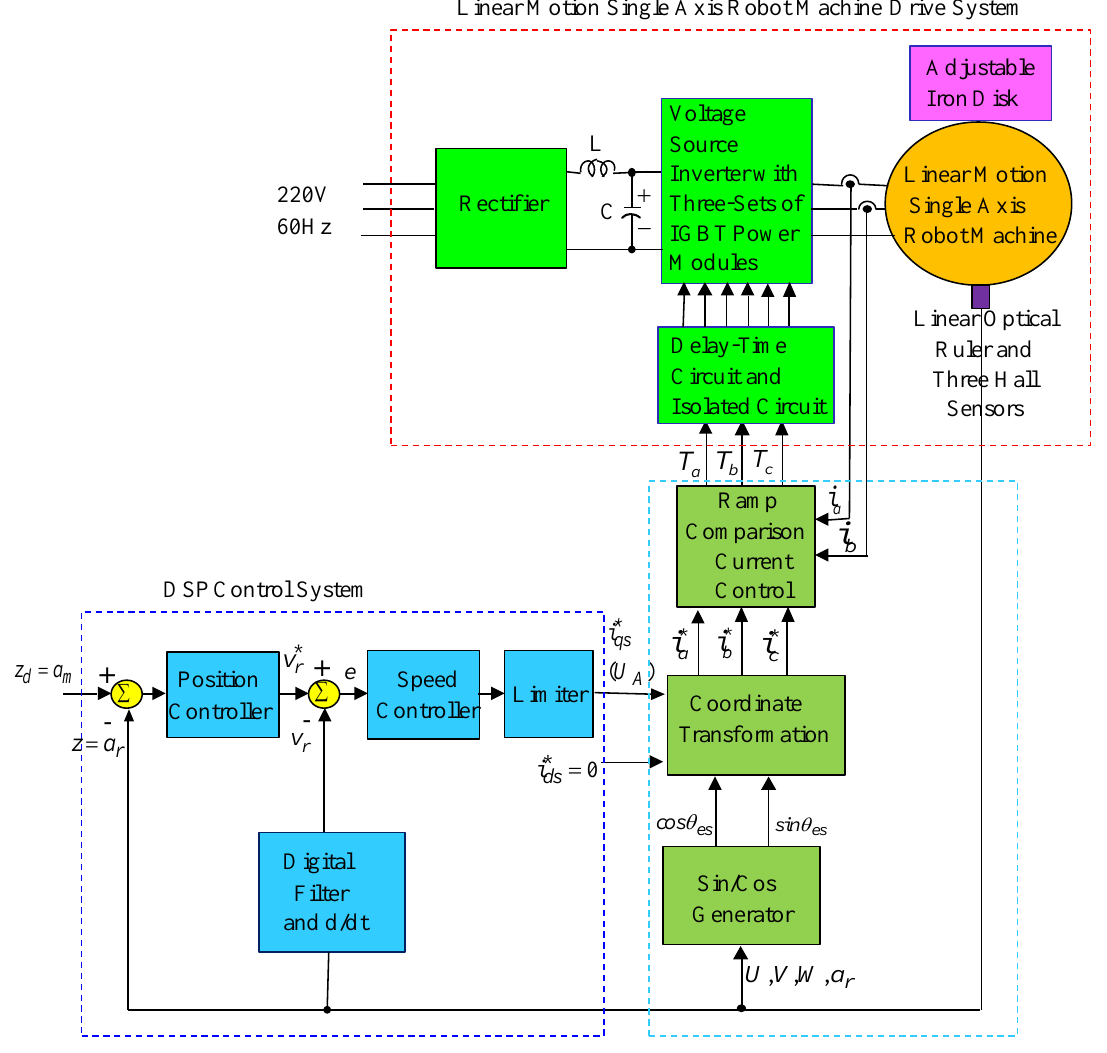
Figure 1. Makeup of linear motion single axis robot machine and drive